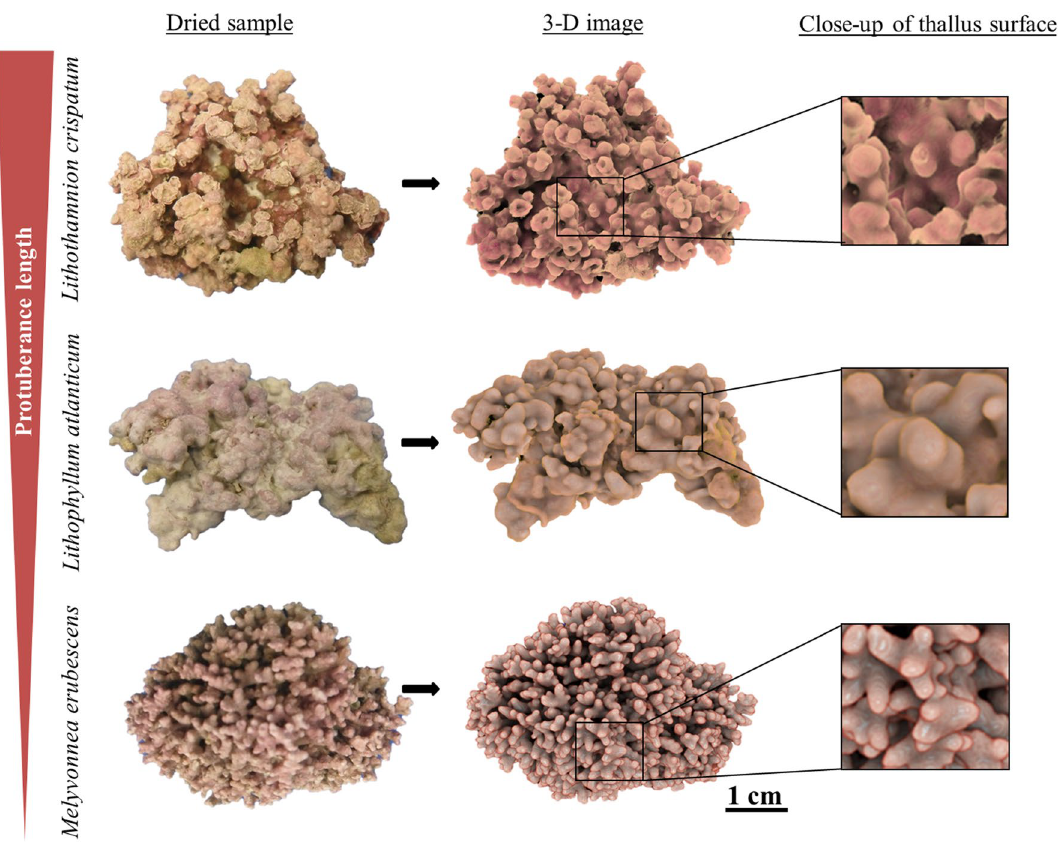
Figure 1. Morphology of the studied rhodolith species: Lithothamnion crispatum shows a lumpy to fruticose morphology and long cylindrical protuberances (~ 15 mm length, 2 mm diameter) 36 flaring distally into curly margined, with funnel-like or cup-shaped tips, Lithophyllum atlanticum has a smooth or warty to lumpy surface with shorter protuberances (5–10 mm length, 3.5 mm diameter) 37 , and Melyvonnea erubescens with its fruticose to warty morphology exhibits branched and even shorter protuberances (1.5–4 mm length, 1–2 mm diameter) 38 . Left row shows images of dried rhodoliths, middle row their respective 3-D images, obtained by X-ray Micro-CT scans, and right row a close-up on the thallus surface. The relative difference in protuberance lengths between species is indicated on the (Fig. 4d–f). In darkness, only L. atlanticum exhibited significantly lower pH values at the protuberance base (0.4 units lower than bulk seawater; ANOVA, p = 0.0005), while the pH at its protuberance tips, as well as at the tips and bases of the other two species, were not different from bulk seawater (Fig. 4d–f). Altogether, this indicated that L. atlanticum experienced high diurnal pH fluctuations at the thallus surface, ranging from 0.37 to 1.18 pH units at protuberance tips and bases, respectively, while the magnitude of fluctuations was much lower in the other two species. The pH DBL in Melyvonnea erubescens exhibited a diurnal pH variability of 0.19–0.64 pH units, while it varied between 0.1 and 0.51 pH units in L. crispatum at protuberance tips and bases, respectively. The species-specific microscale oxygen and pH dynamics within the DBL at the thallus surface were consistent with the species’ metabolic and calcification rates, measured in the organisms as a whole. Between the three stud- ied species, L. atlanticum expressed the highest metabolic rates (photosynthesis and dark respiration) (Table 2), agreeing with the recorded oxygen fluxes at the thallus surface (Fig. 4b). Furthermore, the species’ differences in calcification were consistent with the microscale pH dynamics, as evidenced by the significant direct relationship between the pH difference (mean of protuberance tips and bases) at the algal thallus surface (ΔpH DBL ), compared to the bulk seawater, and the species’ light and dark calcification rates (Fig. 5). Under light conditions, the mean pH DBL value of L. atlanticum was 0.55 units higher than the pH of the overlying bulk seawater and 0.33–0.36 units higher in the other two species, consistent with their differences in light calcification rates (Fig. 5; Table 2). Further, the mean pH DBL in the dark was 0.23 units lower than the bulk seawater in L. atlanticum , agreeing with the species’ negative dark calcification rate, indicative for CaCO 3 dissolution (Table 2). In contrast, in L. crispatum and M. erubescens the mean pH DBL in darkness were 0.0009 pH units higher and 0.06 lower, respectively, associ- ated with lower, but positive calcification in the former species, while M. erubescens also exhibited negative dark calcification rates (Table 2). Thus, between the three species, L. atlanticum , which exhibited the highest metabolic rates and consequently the highest and lowest pH at the algal surface under light and dark conditions, respectively (Fig. 4b, e), also expressed the highest light and lowest dark calcification rate (Fig. 5, Table 2). To study the potential influence of morphology and the aforementioned associated differences in biochemi- cal gradients at the thallus surface on the OA responses of the species, the rhodoliths were exposed to a sudden